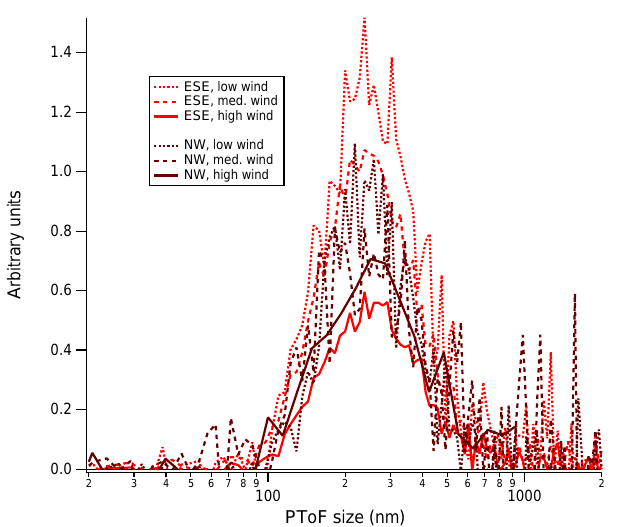
Figure 3. Average d V / dlogD p as a function of volume equivalent diameter for low and medium wind speeds of 2014. Results of the particle time of flight of the sulfate species from the AMS (red) are shown with the SEMS (black) and UHSAS